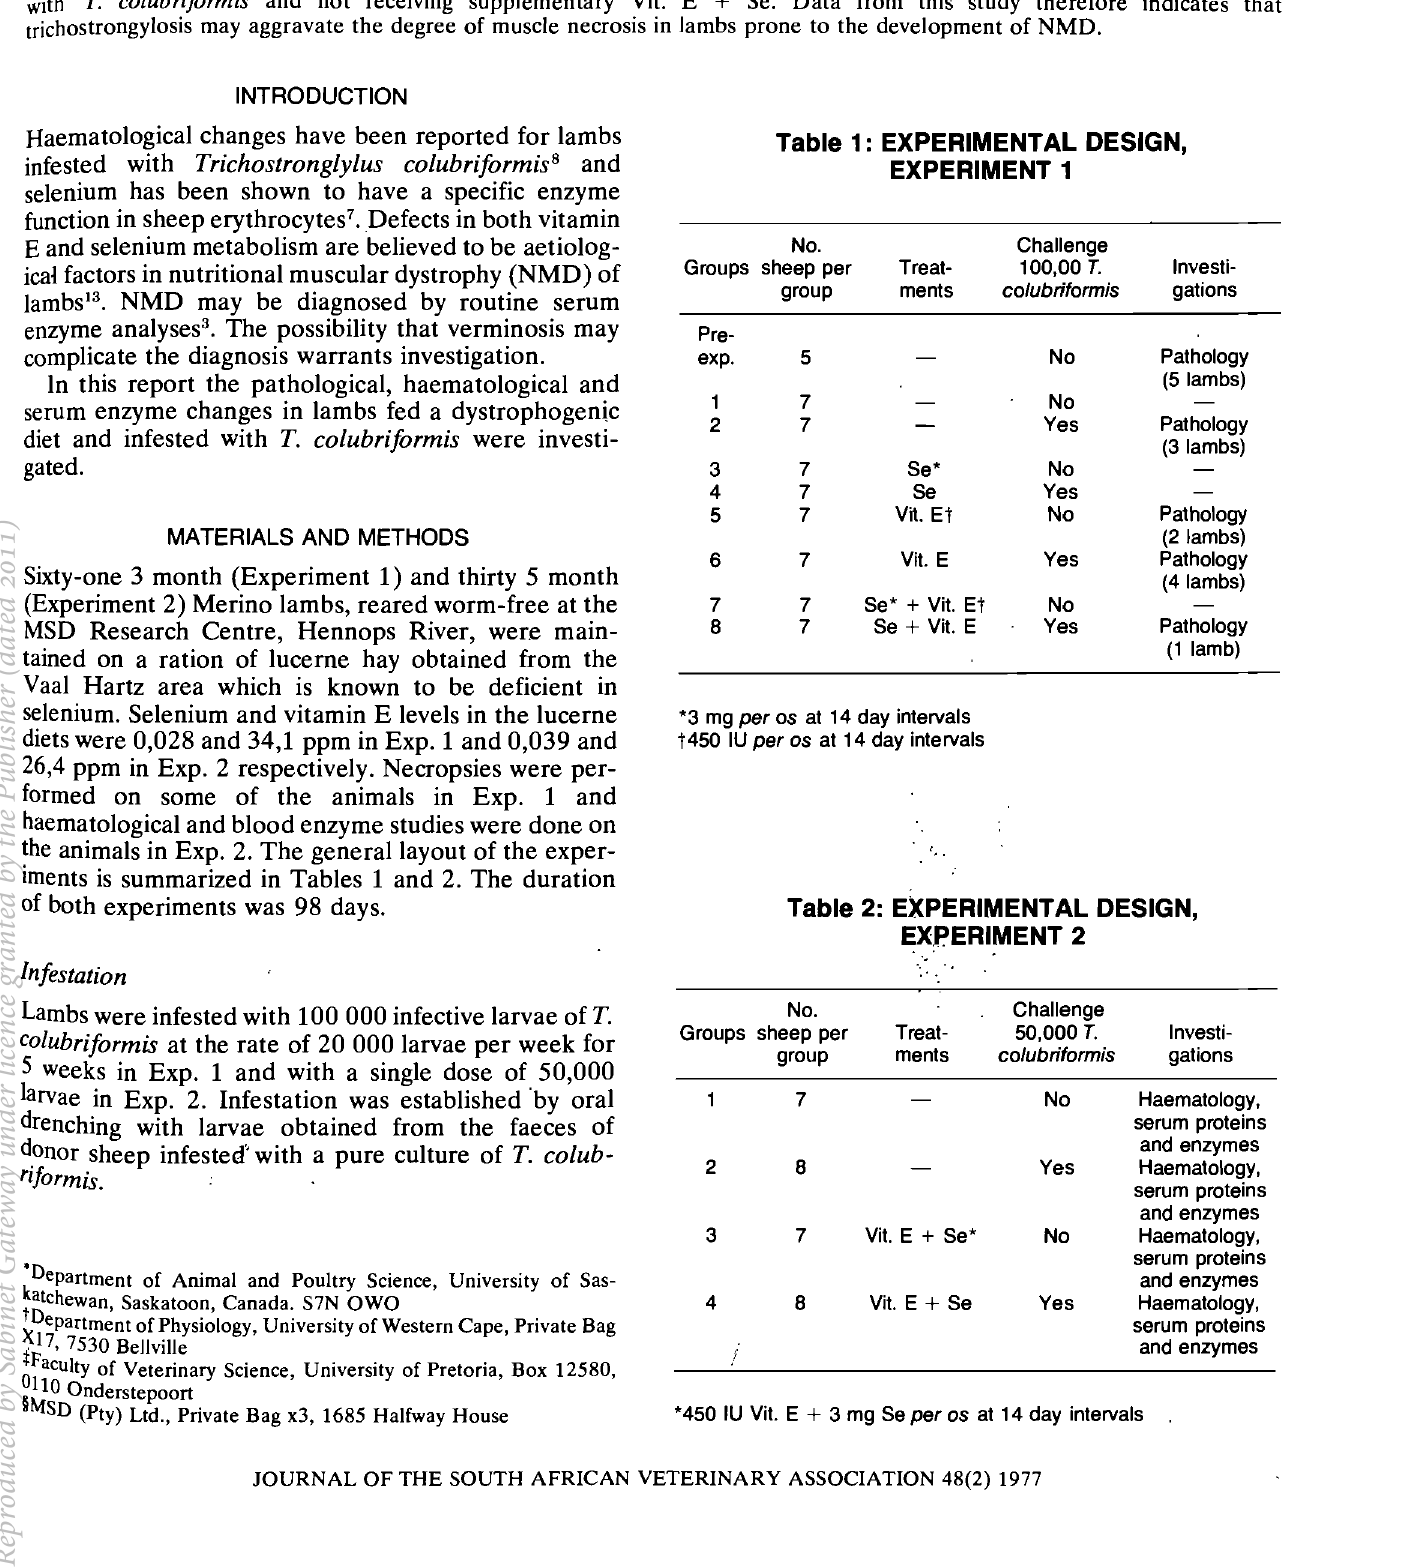
Table 1: EXPERIMENTAL DESIGN, EXPERIMENT 1